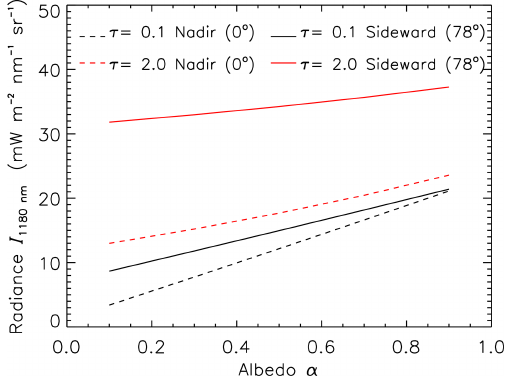
Figure 5. Influence of the surface albedo α on the measured upward radiance I V at λ = 1180nm as a function of cirrus optical RTS , 1180 thickness τ and sensor orientation θ V